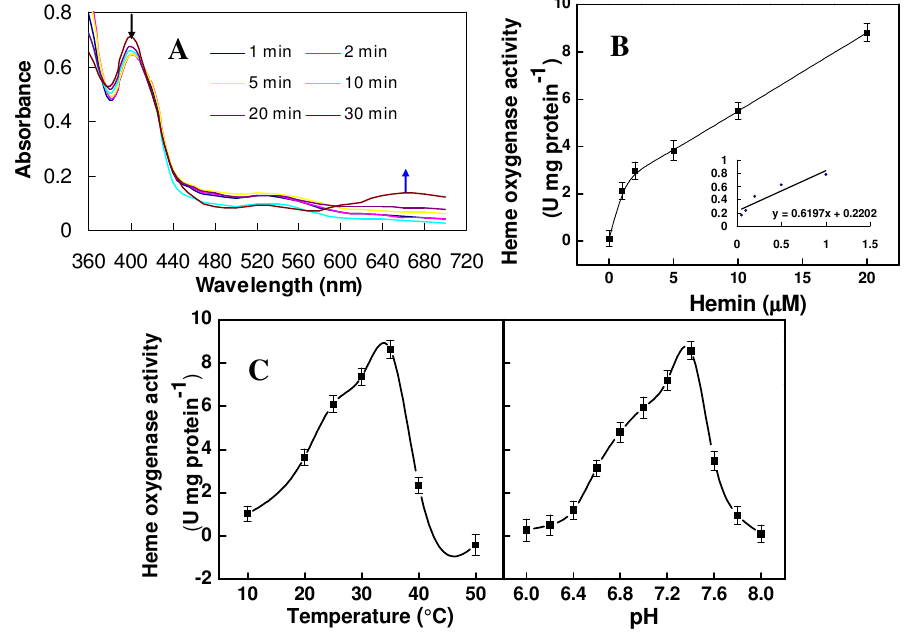
Figure 4. Biochemical characterization of purified recombinant mTaHO1. ( A ) Time- dependent absorbance changes were determined during the mTaHO1 reaction with spectra between 360 and 700 nm taken at 1, 2, 5, 10, 20 and 30 min after the addition of NADPH. The black arrow indicates the degradation of hemin and the blue arrow stands for the generation of BV; ( B ) Michaelis-Menten plot of the mTaHO1 reaction for hemin concentrations of 1, 2, 5, 10 and 20 µ M. Insert: Lineweaver-Burk plot of the same data; ( C ) Temperature (left) and pH (right) dependence of the mTaHO1 reaction. Data shown are the means ± SD from three independent